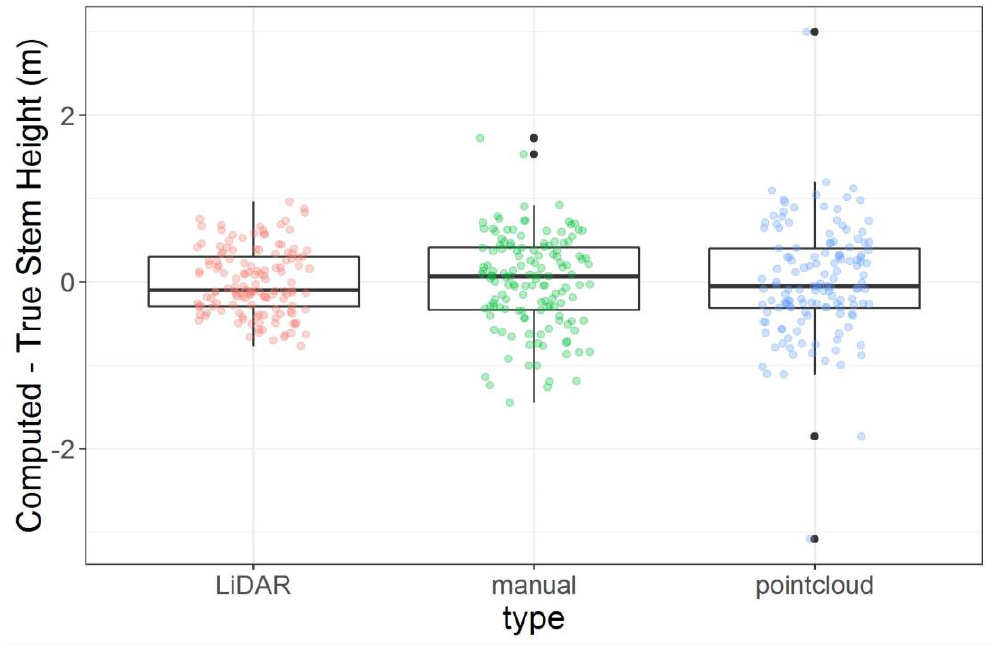
Figure 6. Distribution of differences between computed (predicted) and true (observed) vegetation height after transformation for each of the three methods: LiDAR, manual, and point cloud.